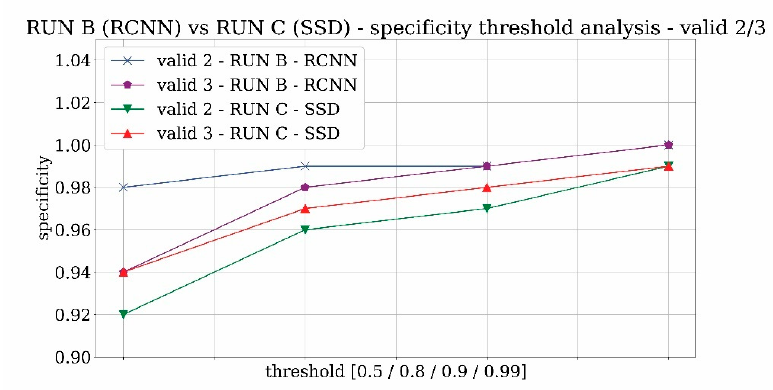
Figure 14. Sensitivity threshold analysis for RUN B and RUN C with valid 1 and 4.